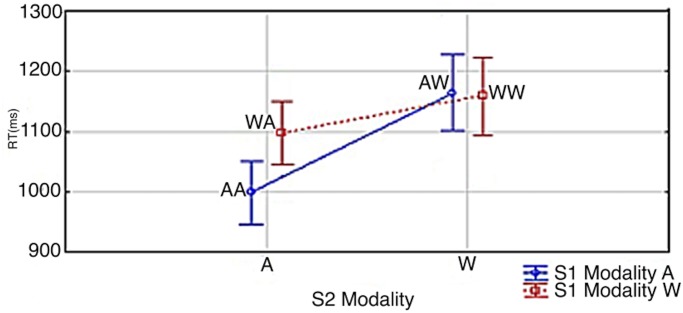
S1 Modality x S2 Modality.Vertical bars denote 0.95 confidence intervals for repeated measures ANOVA (Hollands & Jarmasz, 2009). S1 and S2 modality is signified by ‘A’ and ‘W’; i.e. Arabic Digit (A) vs. Written Number Word (W). As an example, AW signifies an Arabic digit at S1 and a written number word at S2.